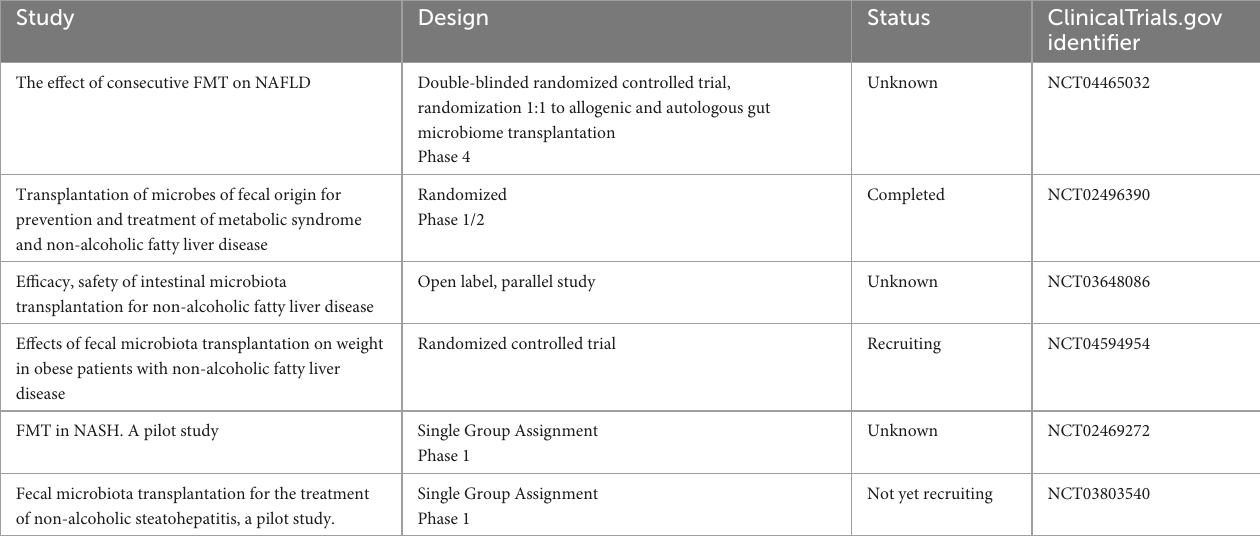
TABLE 3 Ongoing trials investigating the application of fecal microbial transplantation (FMT) in non-alcoholic fatty liver disease (NAFLD)/non-alcoholic steatohepatitis (NASH) treatment.